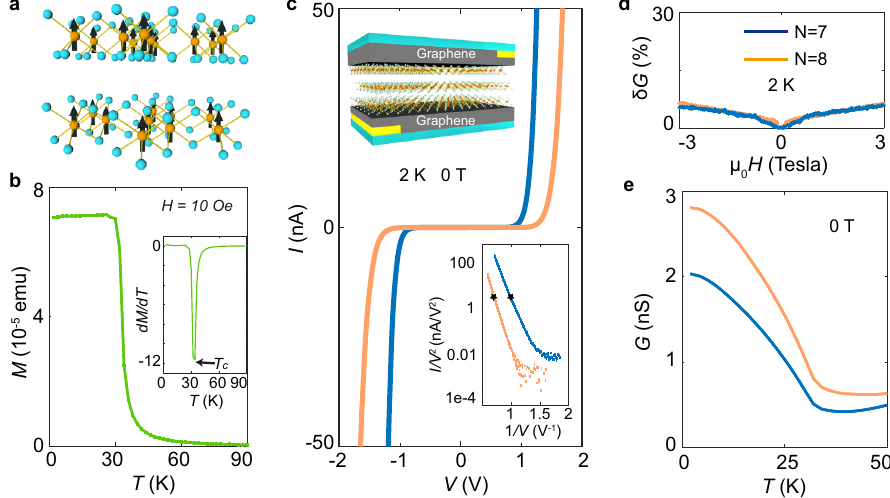
Fig. 1 Tunneling conductance of CrBr 3 multilayers. a Schematics of the crystal structure of CrBr 3 : the orange balls represent the Cr atoms with the associated spins pointing perpendicularly to the layers; the light blue balls represent the Br atoms. b Temperature dependence of the magnetization measured on bulk CrBr 3 crystals with a magnetic fi eld of 1 mT applied perpendicular to the layers. The inset shows the plot of dM / dT , with a sharp minimum close to 32 K, corresponding to the Curie temperature of CrBr 3 . c Tunneling current as a function of applied voltage measured on a 7 (blue curve) and 8 (orange curve) layer CrBr 3 device at T = 2 K (curves of the same color in panels d and e represent data measured on the same devices). The up left inset is a cartoon representation of our hBN-encapsulated graphene/CrBr 3 /graphene tunnel junction devices. The down right inset shows that -for suf fi ciently large applied bias V - log ð I = V 2 Þ is linearly proportional to 1/ V , as expected in the Fowler – Nordheim tunneling regime. To avoid Joule heating problems, we used relatively small bias voltage (as discussed in ref. 15 ; V = 1 V and V = 1.4 V for the 7 and 8 layer devices, respectively) to measure the temperature and magnetic fi eld dependence of the conductance shown in this and later fi gures, represented by the stars in the inset. d Magnetoconductance δ G ( H , T ) ≡ [ G ( H , T ) − G (0, T )]/ G (0, T ) measured at T = 2 K on the 7 and 8 layer devices. The magnetic fi eld is applied perpendicular to the CrBr 3 ab -plane. e Temperature dependence of the zero- fi eld tunneling conductance of the 7 and 8 layer devices, exhibiting an increase of approximately 300%, as T is lowered from T c to 2 K.